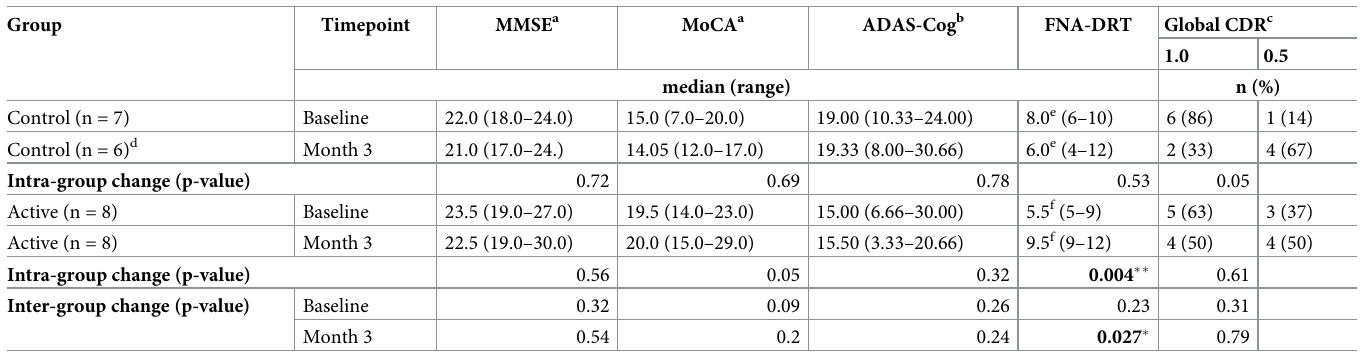
Table 4. Changes in clinical characteristics in Phase 2A study participants after 3